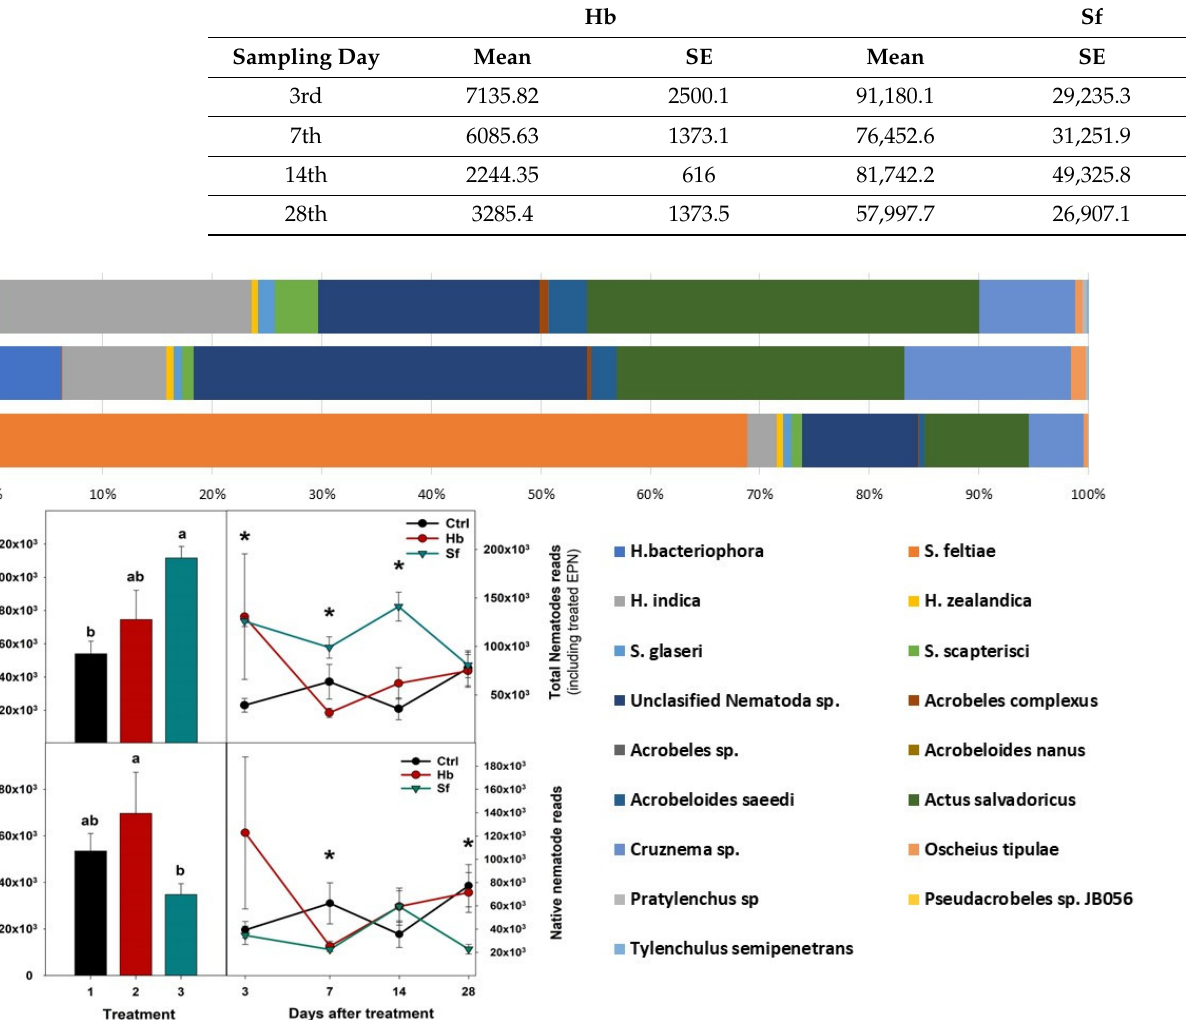
Table 1. Abundance of Steinernema feltiae (Sf) and Heterorhabditis bacteriophora (Hb) for 28 days fol- lowing augmentation in a citrus orchard.